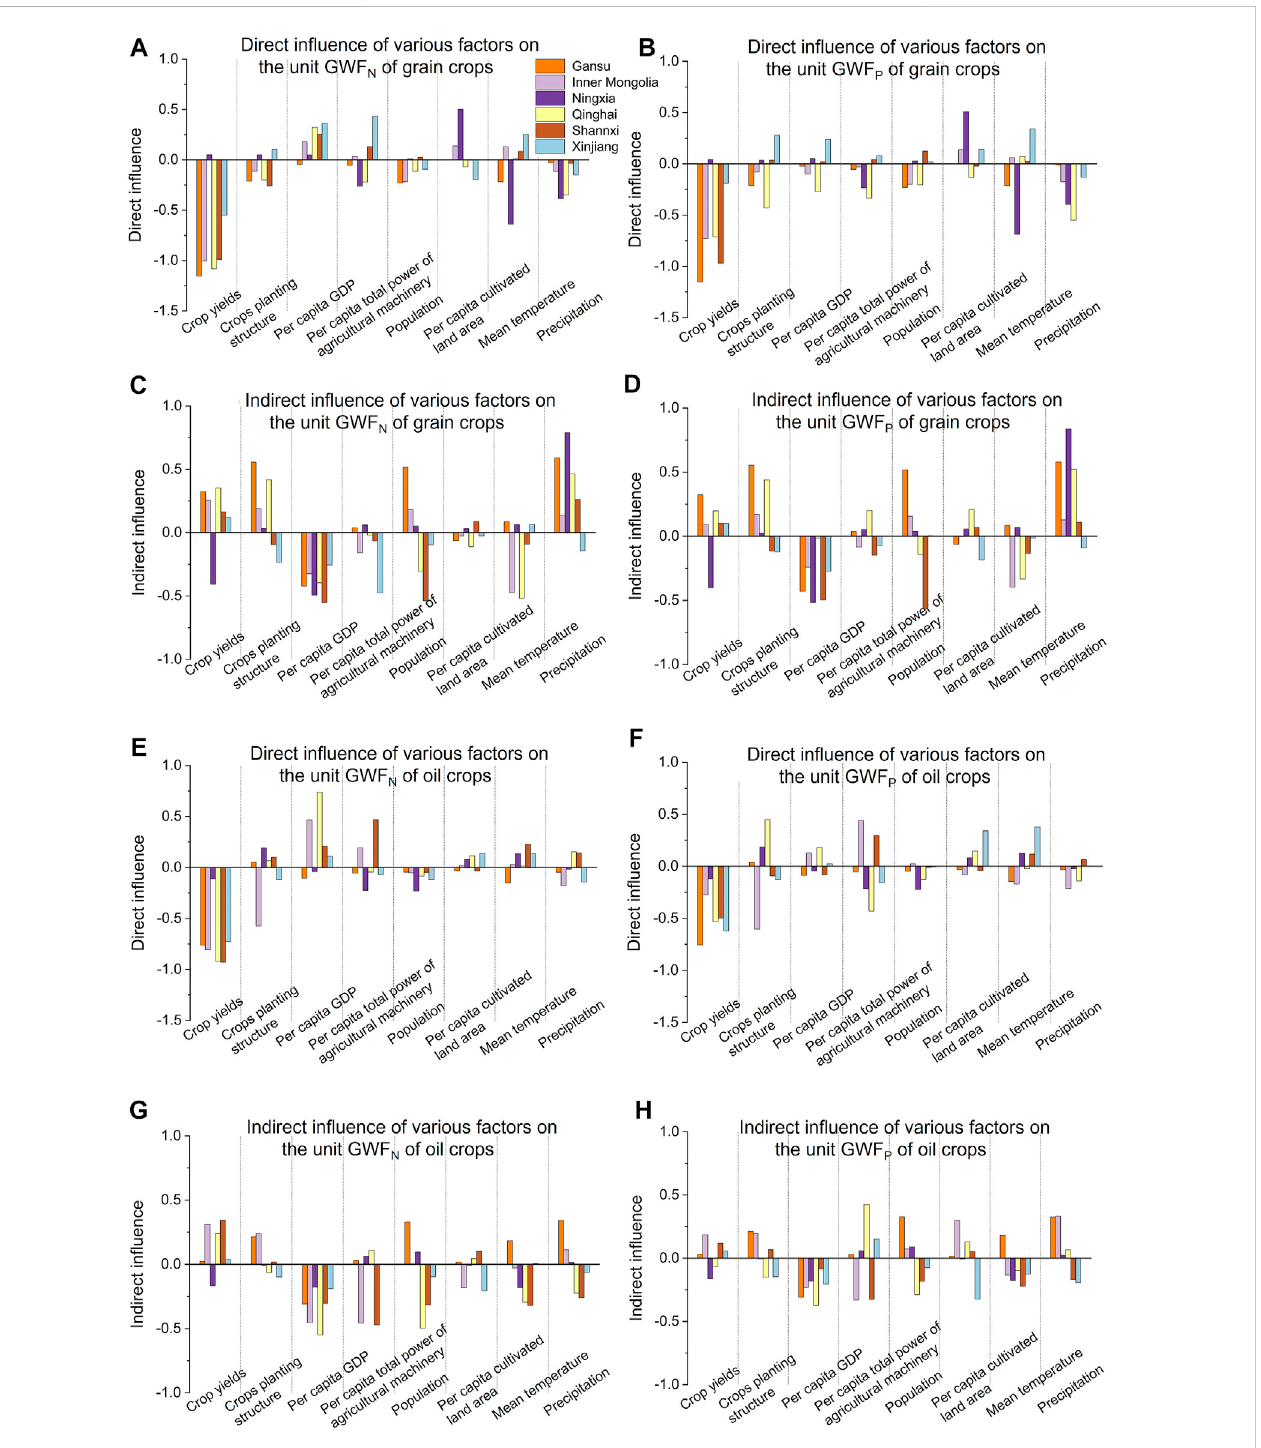
FIGURE 8 Direct and indirect effects of various factors on the unit GWF of grain crops and oil crops in the six western provinces: (A,B) direct effects of various factors on the unit GWF related to N (left) and P (right) of grain crops; (C,D) indirect effects of various factors on the unit GWF related to N (left) and P (right) of graincrops; (E,F) directeffectsofvariousfactors ontheunitGWFrelatedtoN(left)andP(right)ofoilcrops; (G,H) indirecteffectsofvariousfactorsontheunit GWF related to N (left) and P (right) of oil